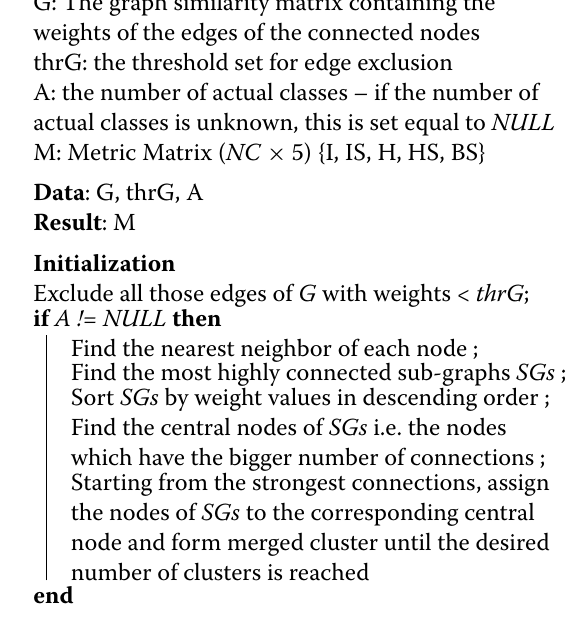
Algorithm 3: Graph Merging